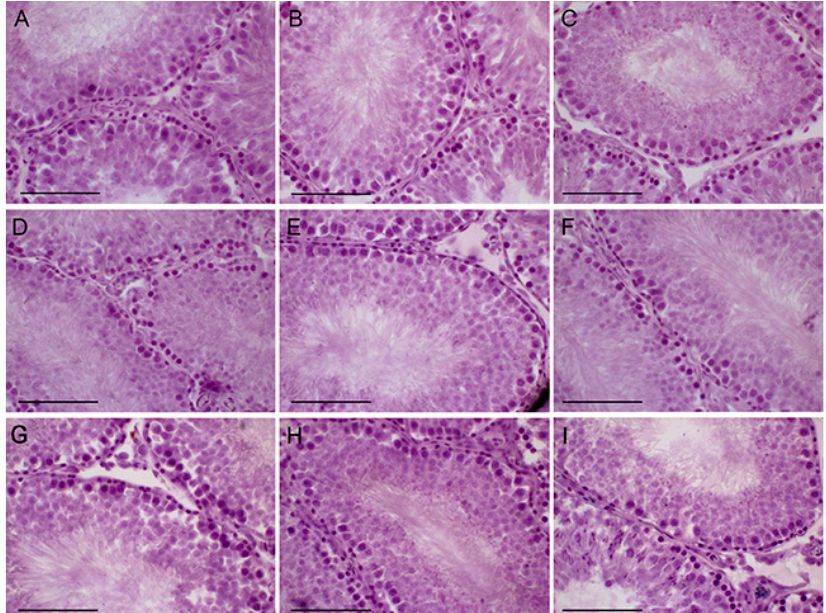
Figure 6. The histochemical analysis of the seminiferous tubules in the testes of control and diabetic rats, and the effect of long-term metformin treatment and five-day treatment with LH/hCG-R-agonists. ( A )—C5, ( B )—CT5, ( C )—CG5, ( D )—D5, ( E )—DT5, ( F )—DG5, ( G )—DM5, ( H )—DMT5, ( I )—